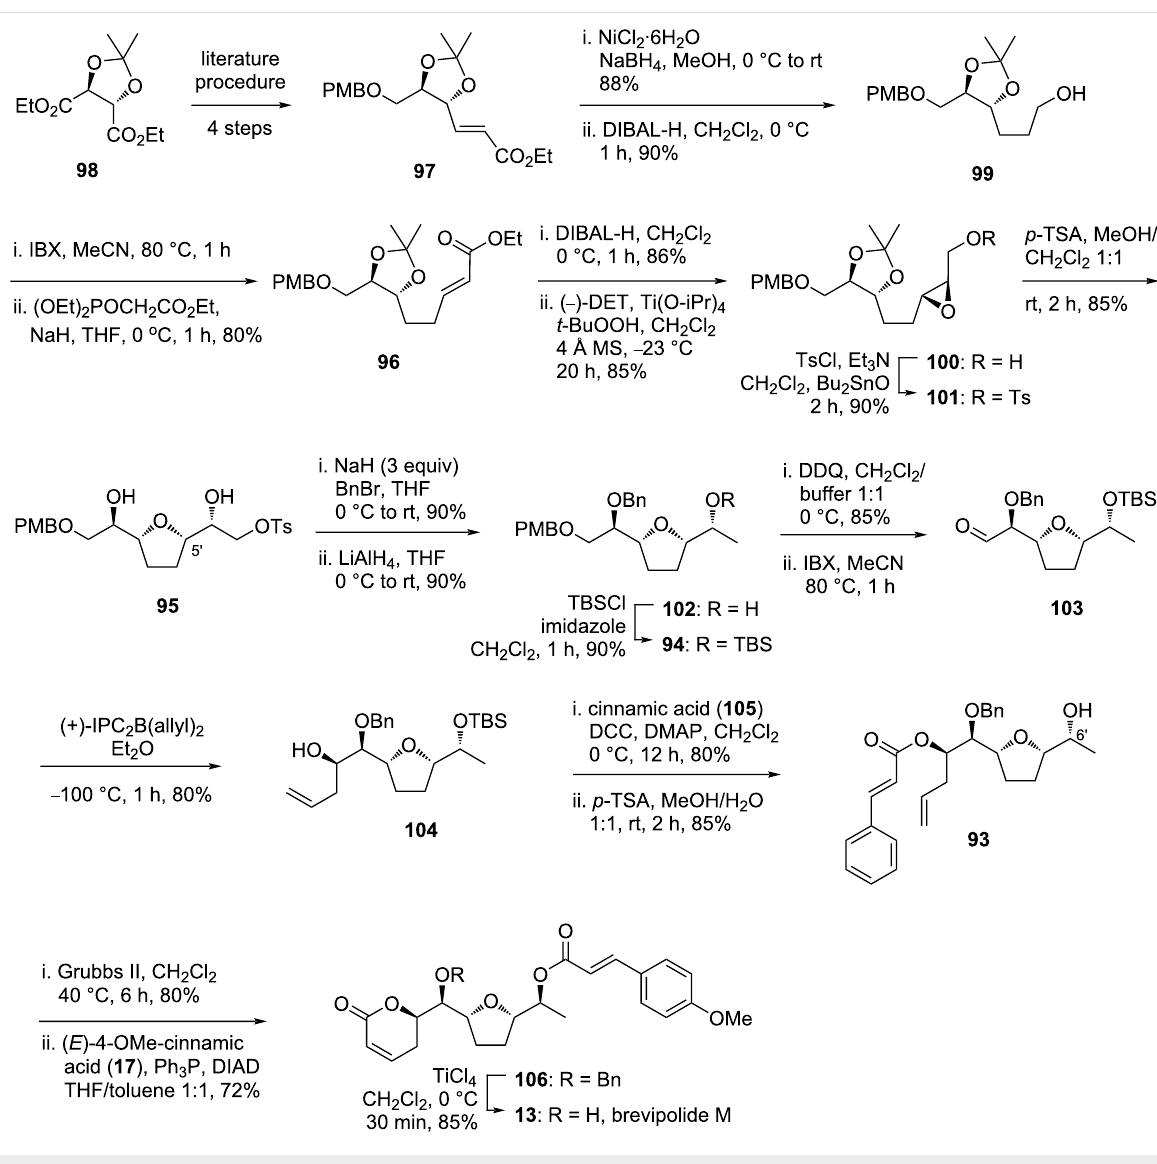
Scheme 12: Synthesis of brevipolide M ( 13 ) by